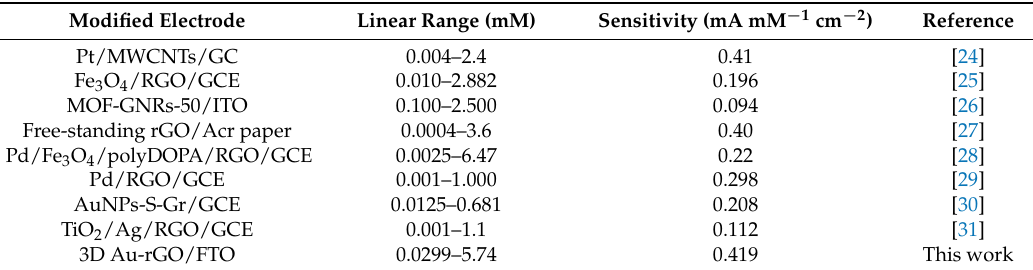
Table 1. Comparison of different modified electrodes for nitrite determination.